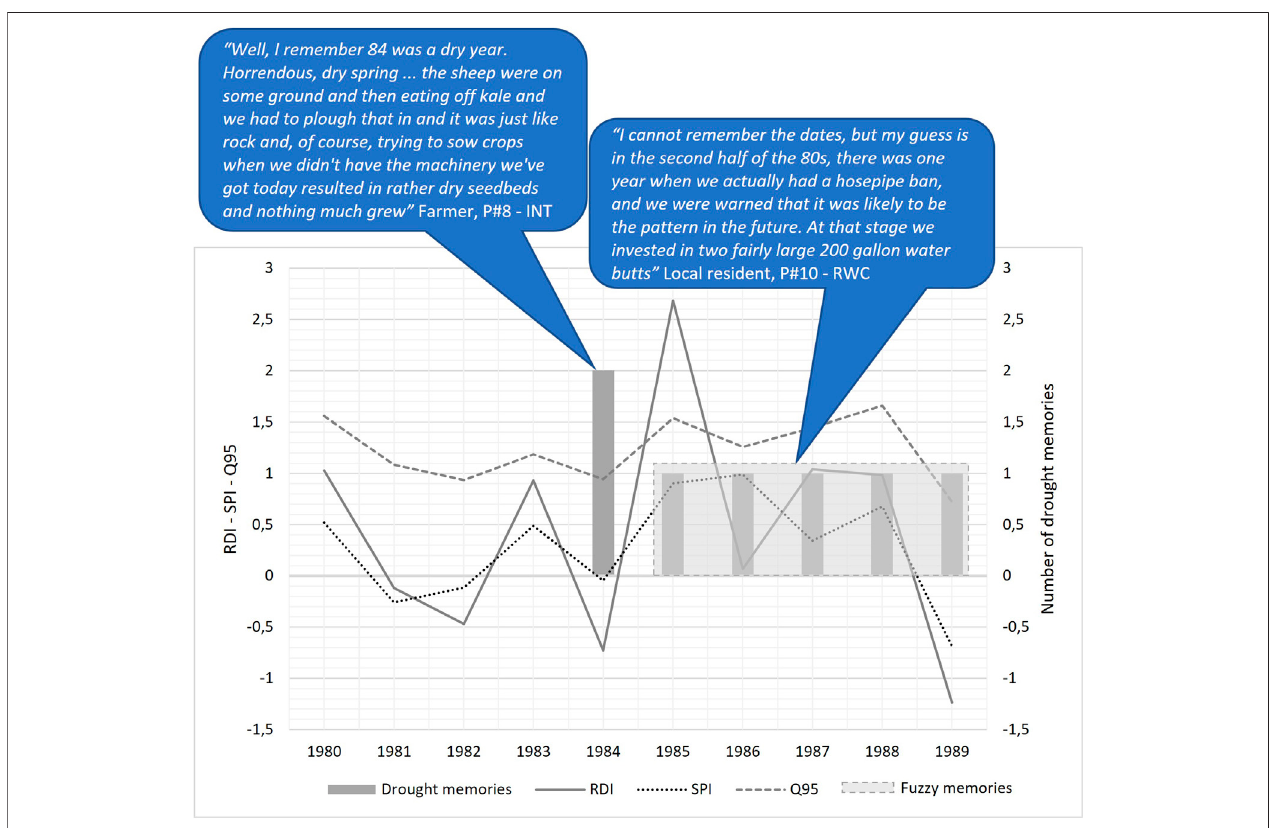
FIGURE 9 | Drought memories overlaid on SPI, RDI and Q 95 data for the decade 1980 to 1989.